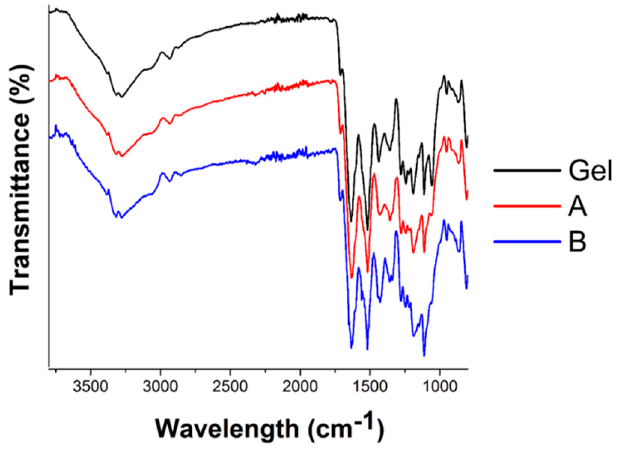
Figure 5. FT-IR spectra of the gel and the nanocomposites.